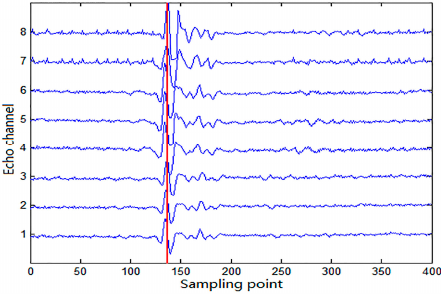
Figure 12. The waveforms of 8-channel defect echo signals.